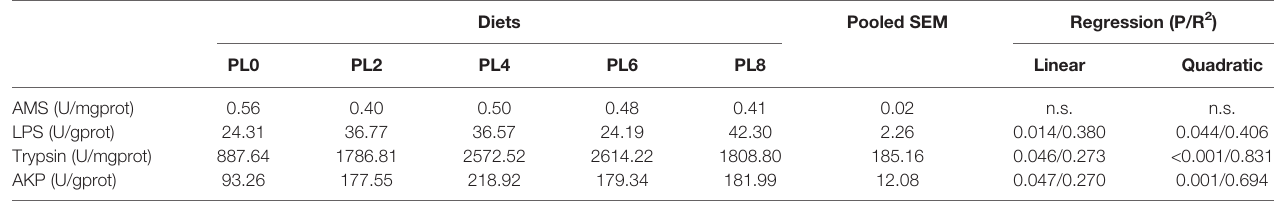
TABLE 5 | The activities of digestive enzymes in the intestine of largemouth bass larvae fed with experimental diets for 28 days * . Diets Pooled SEM